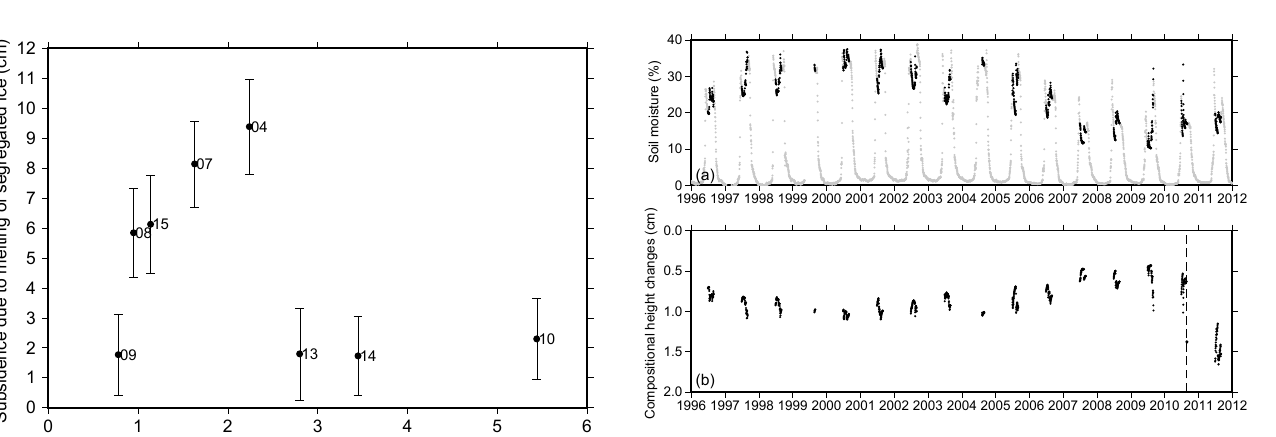
Figure 8. (a) Daily soil moisture at 5cm depth, measured at the CALM Barrow soil–climate site U1-1. Black dots and gray dots denote records during July–August and in other months, respec- tively. The records have data gaps in the summers of 2000 and 2004. (b) The simulated changes of compositional height in July and Au- gust. Because an increase in compositional height can be potentially mistakenly interpreted as an apparent ground surface subsidence, the vertical axis of this figure is flipped to facilitate comparison with subsidence plots such as Fig. 4a. The vertical dashed line denotes the date of antenna change (i.e., 24 August